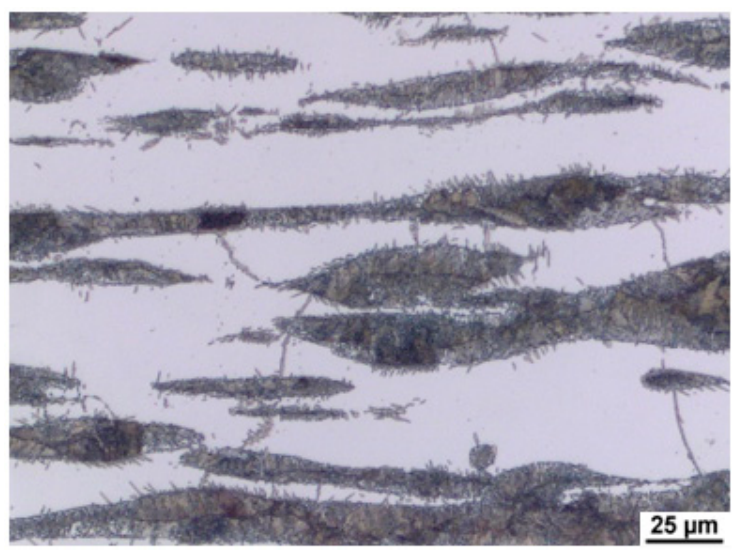
Figure 8. Microstructure of the hot-rolled sheet. Heat B. Longitudinal direction.